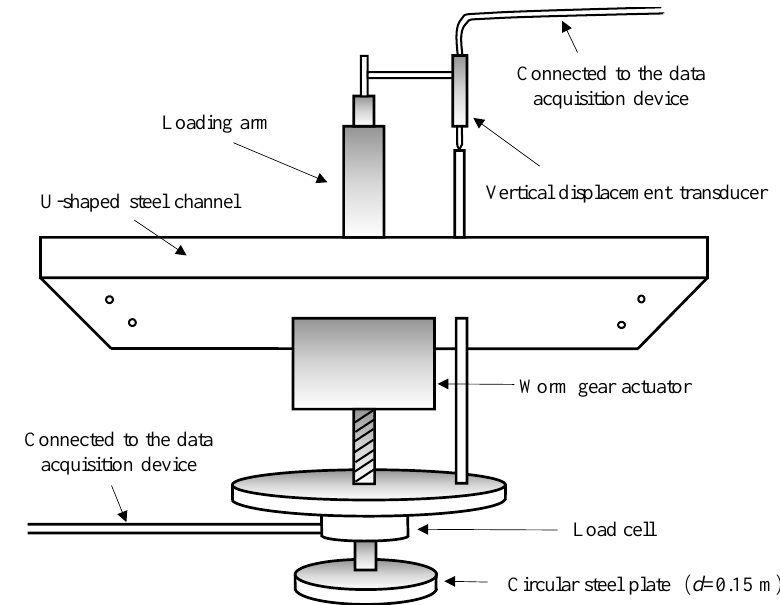
Figure 4. Diagrammatic sketch of the loading system.